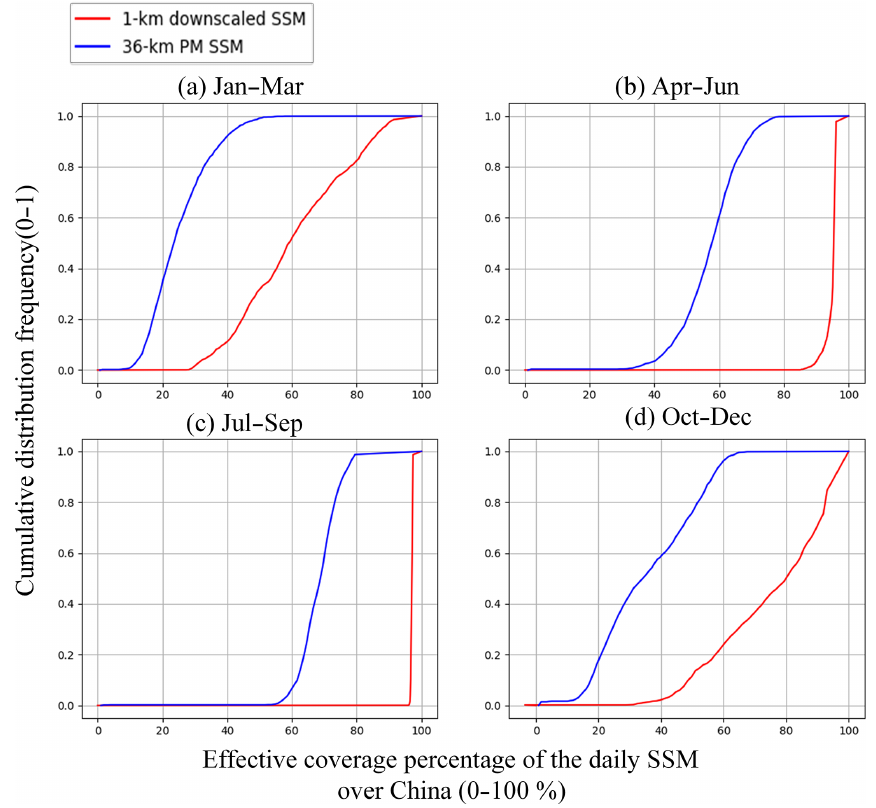
Figure 7. Cumulative distribution frequency of our proposed SSM product against the original 36km SSM product for different seasons. The period between October 2011 and June 2012 is excluded in the current